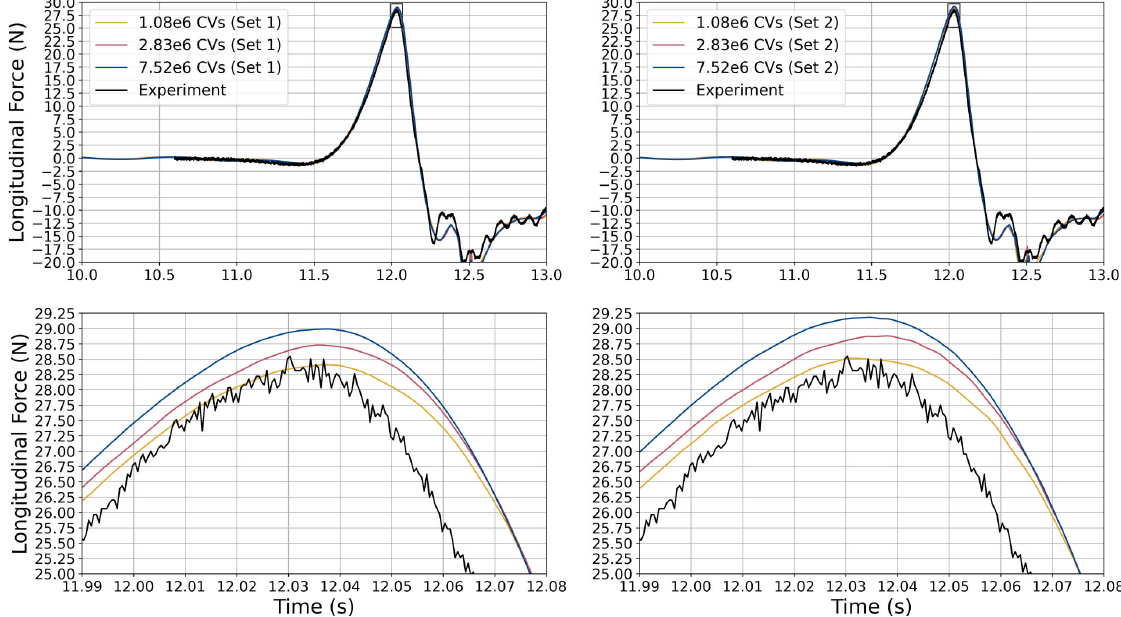
Figure 4. Time histories of wave-induced loads acting on the large cylinder obtained on the three grids of set 1 ( top left ) and set 2 ( top right ) and zoomed views of the associated load peaks of set 1 ( bottom left ) and set 2 ( bottom right ) based on the laminar flow model.